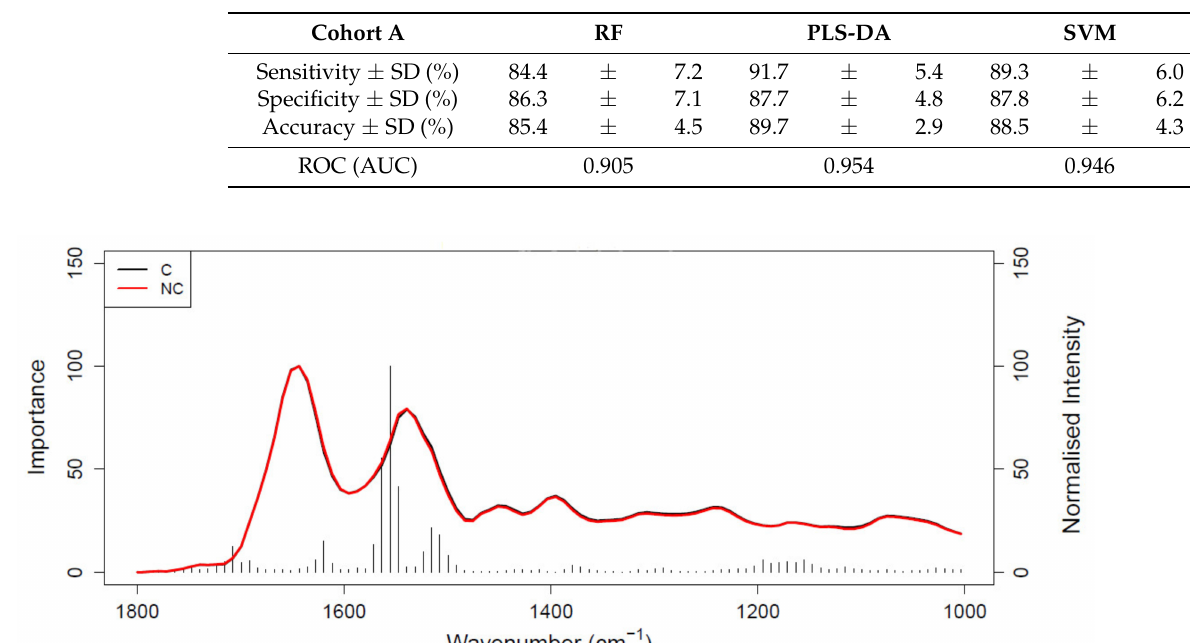
Figure 1. Receiver operating characteristic (ROC) curve analysis calculated from a partial least squares discriminant analysis (PLS-DA) model performed on Cohort A. The colored box indicates the region with sensitivity and specificity greater than 60%. The orange dots indicate the points within that region that have maximum sensitivity (A), maximum specificity (B), and balanced sensitivity and specificity (C) (Sens, sensitivity; Spec, specificity; AUC, area under the ROC curve). Table 2. Statistical performances of random forest (RF), partial least squares discriminant analysis (PLS-DA), support-vector machine (SVM), and receiver operating characteristic (ROC) analysis performed on Cohort A (AUC, area under the ROC curve; SD, standard deviation).